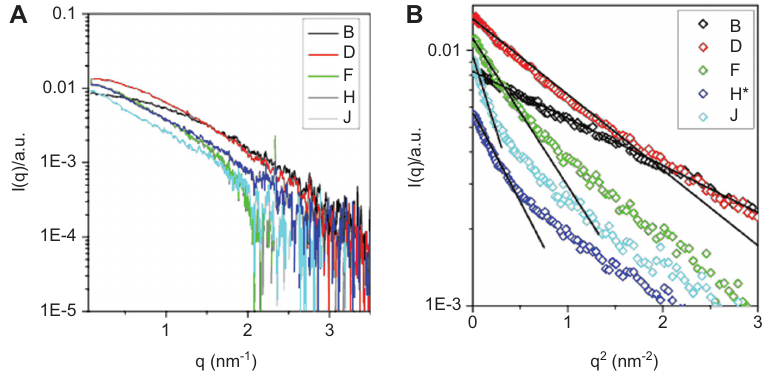
Figure 4 Scattering profiles of Pd NPs from different AF4 fractions (A) and the corresponding Guinier plots (B) (* shifted for clarity, for explanation of the legend see Table